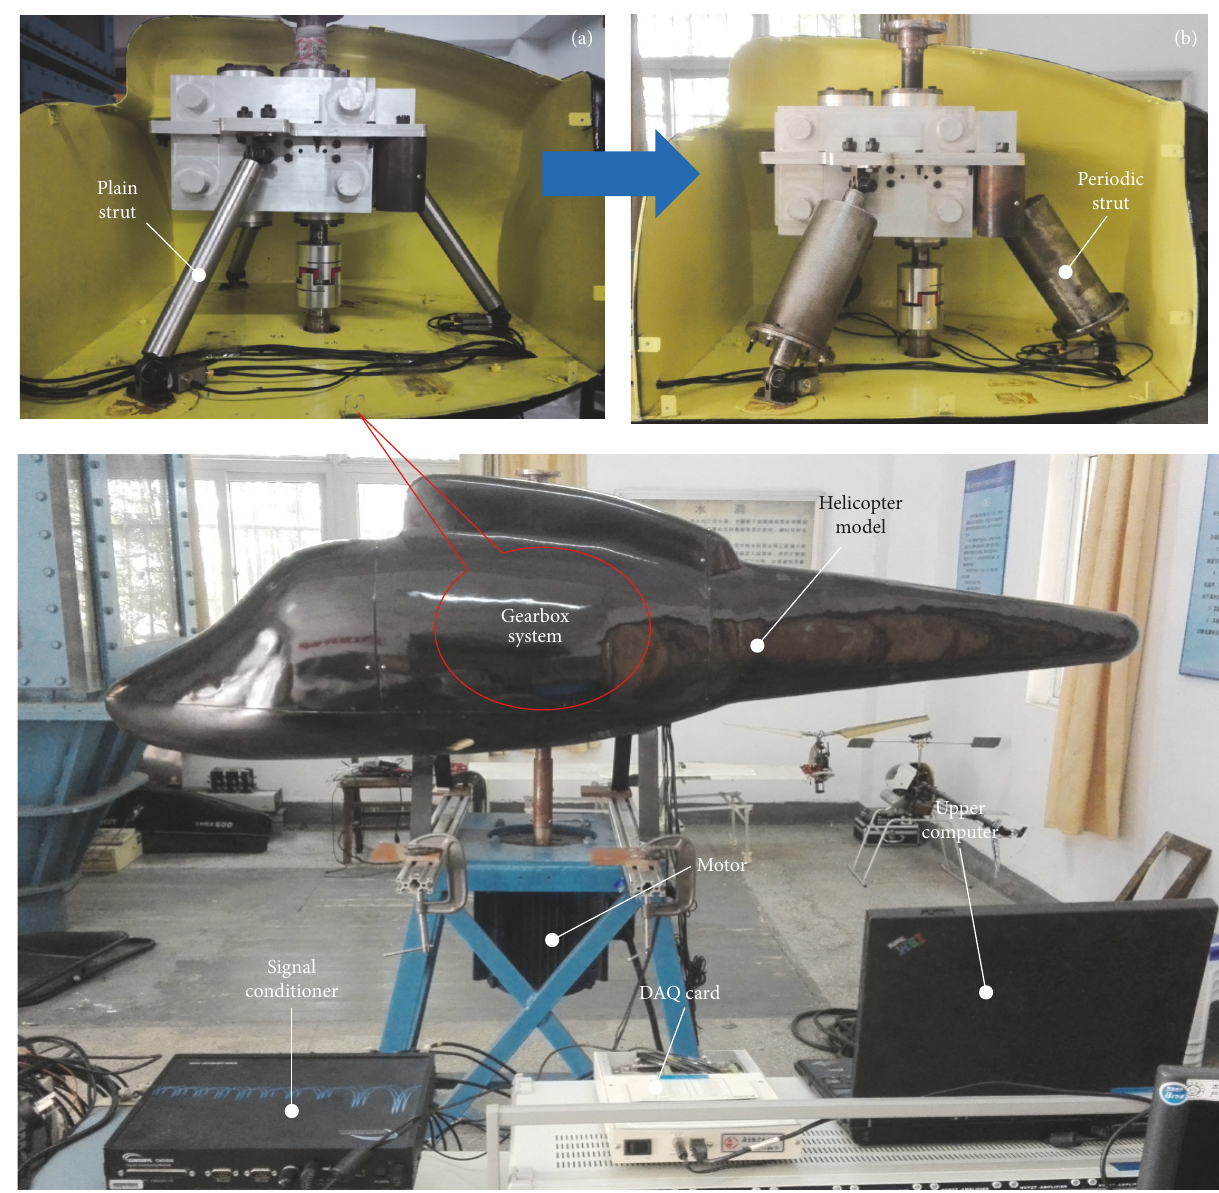
Figure 9: Experimental setup of gearbox excitation.